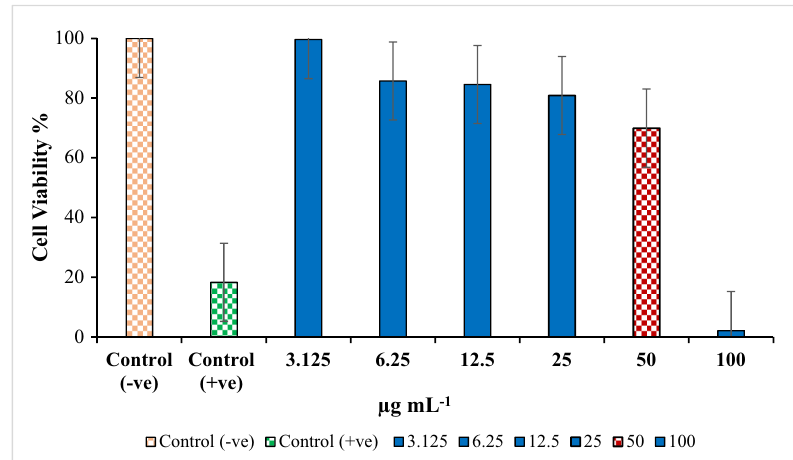
Figure 6: In vitro cytotoxic activity of Ag - NPs synthesized using Aloe vera gel extract against B16F10 cell line.